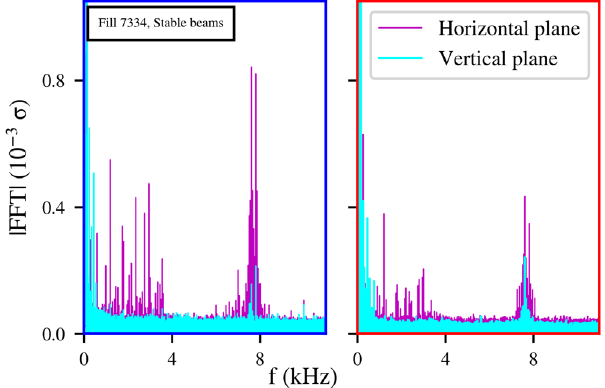
FIG. 18. The maximum amplitude of the 50 Hz harmonics for the horizontal (magenta) and vertical plane (cyan) of Beam 1 (blue) and 2 (red) for all the proton physics fills of 2018.